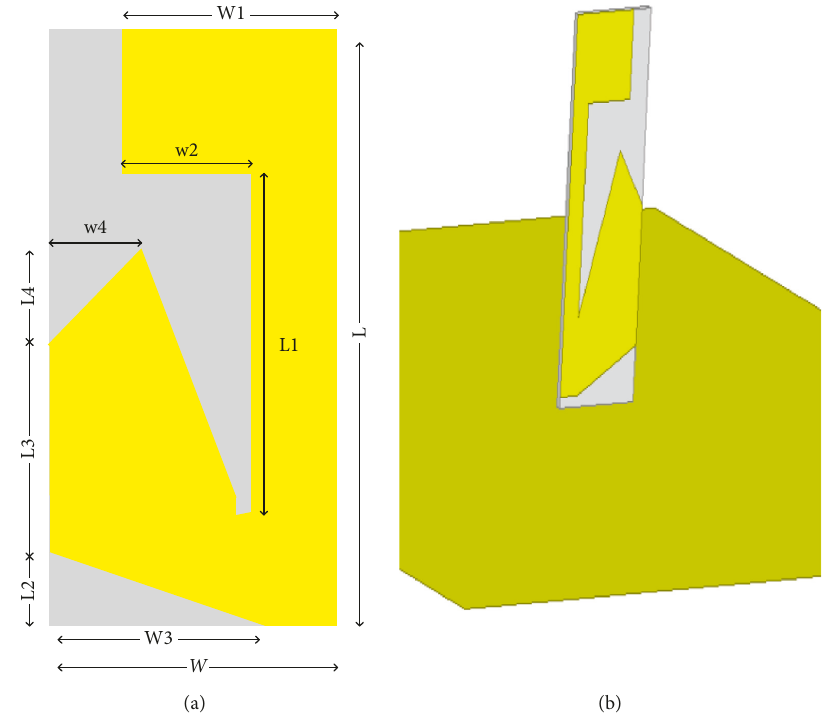
Figure 1: Structure of the two-branch vehicle antenna: (a) planar structure diagram; (b) stereoscopic structure diagram. Table 1: Antenna size parameters. Parameters Values